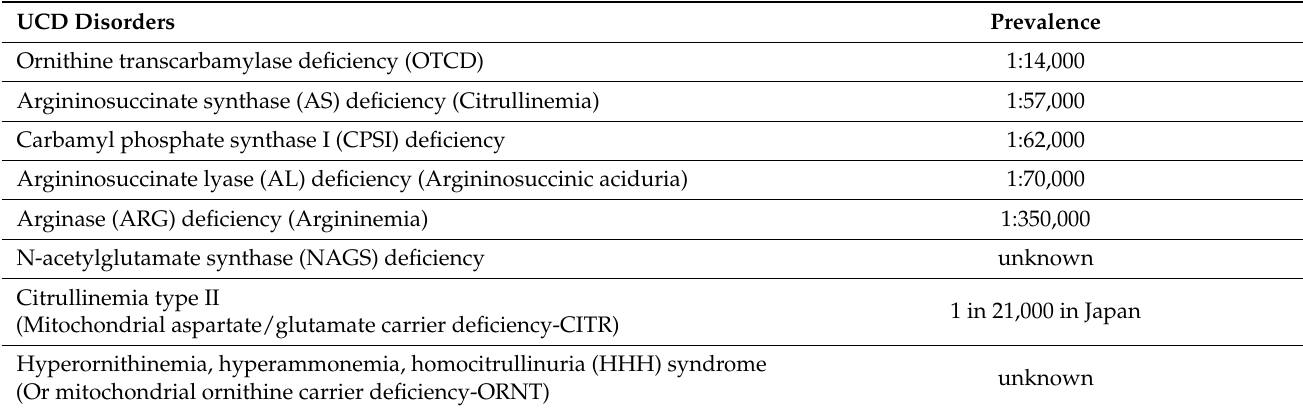
Table 1. The specific UCD disorders and estimated prevalence